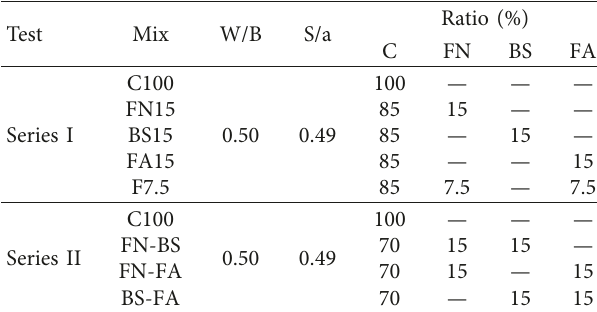
Table 2: Experimental